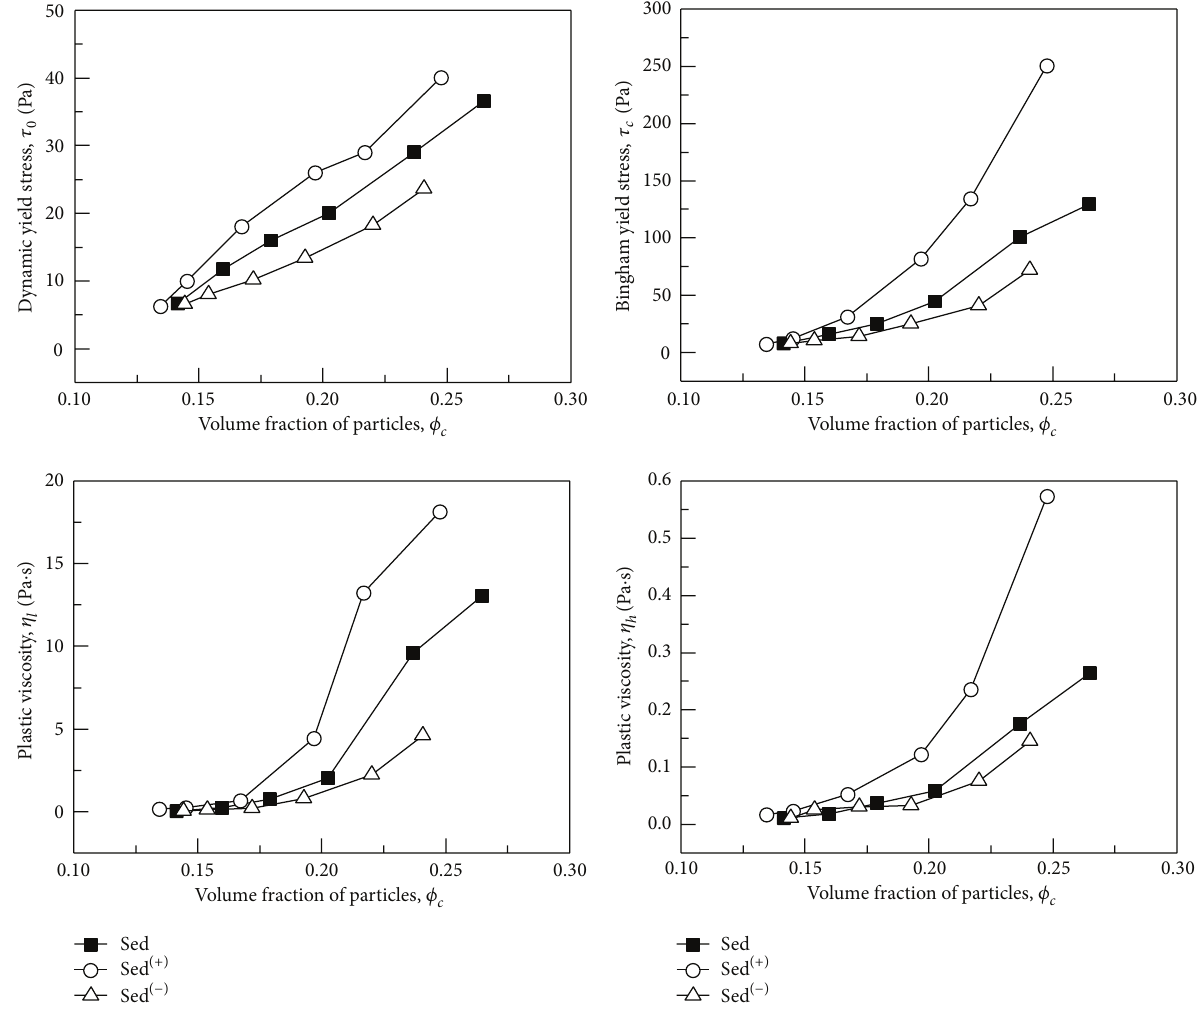
Figure 6: Bilinear rheological parameters of Group Sed, Group Sed (+) , and Group Sed (−)